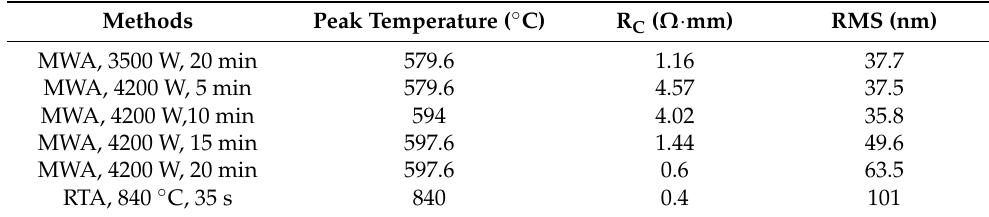
Figure 11. The schematic diagrams of MWA equipment. Reprinted with permission from Ref. [89]. Copyright 2017, IEEE. Table 3. Comparisons of peak temperature, R C , and RMS characteristics for various annealing conditions. Reprinted with permission from Ref. [90]. Copyright 2016, IEEE.